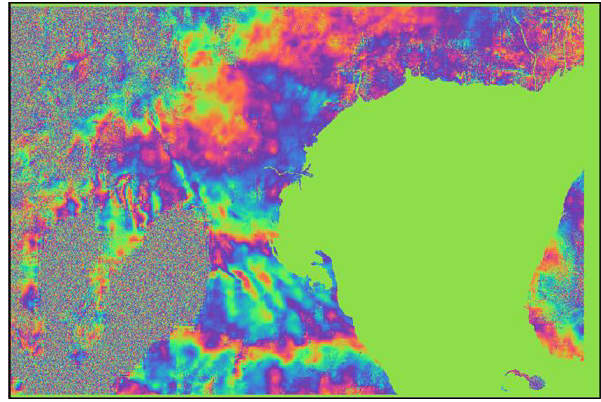
Figure 8. Filtered